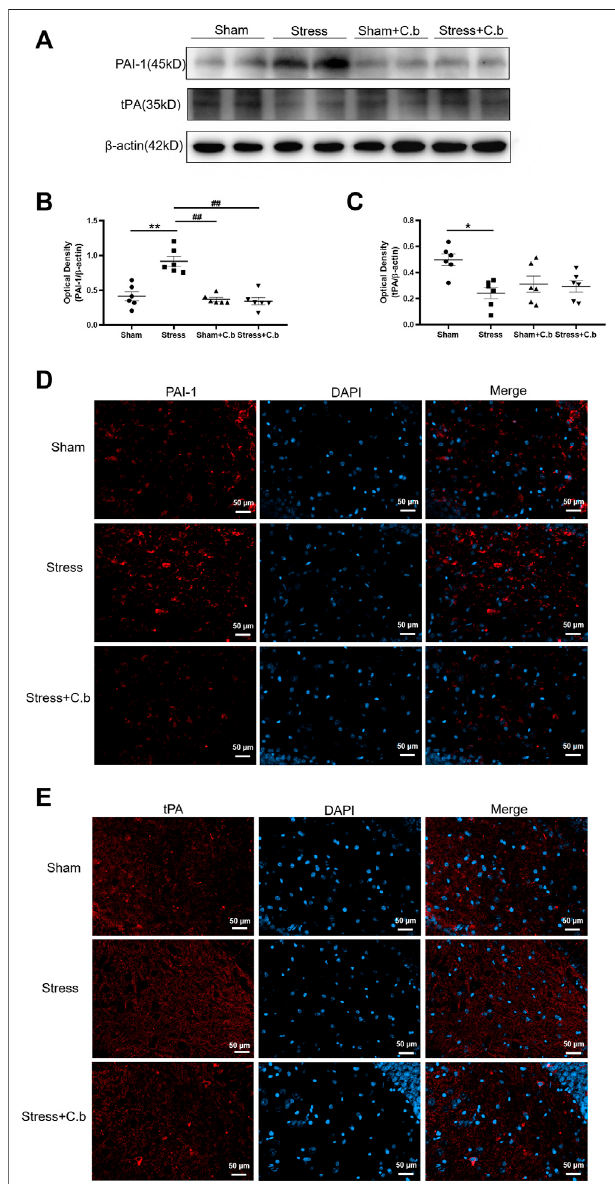
FIGURE 7 | C. butyricum RH2 treatment reversed CFSS-induced upregulation of PAI-1 in the hippocampus. (A – C) Western blot analysis of expressionofPAI-1andtPAinthehippocampusofCFSSratsbeforeandafter C. butyricum RH2 treatment. (D – E) The immunoreactive spots of PAI-1 and tPA protein in the hippocampus of CFSS rats before and after C. butyricumRH2treatment.* p < 0.05,** p < 0.01versusshamgroup;# p < 0.05, ## p < 0.01 versus stress group; ^ p < 0.05, ^^ p < 0.01 versus stress + C. butyricum group.